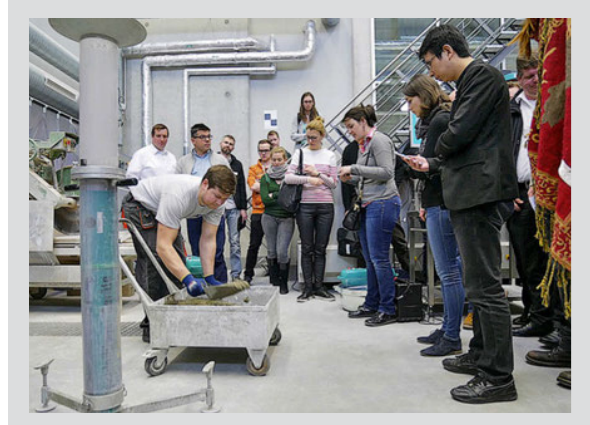
Figure 3: Workshop about the thermal conductivity measure- ment on building materials with Henry Taubmann, CEO of C3 Prozess- und